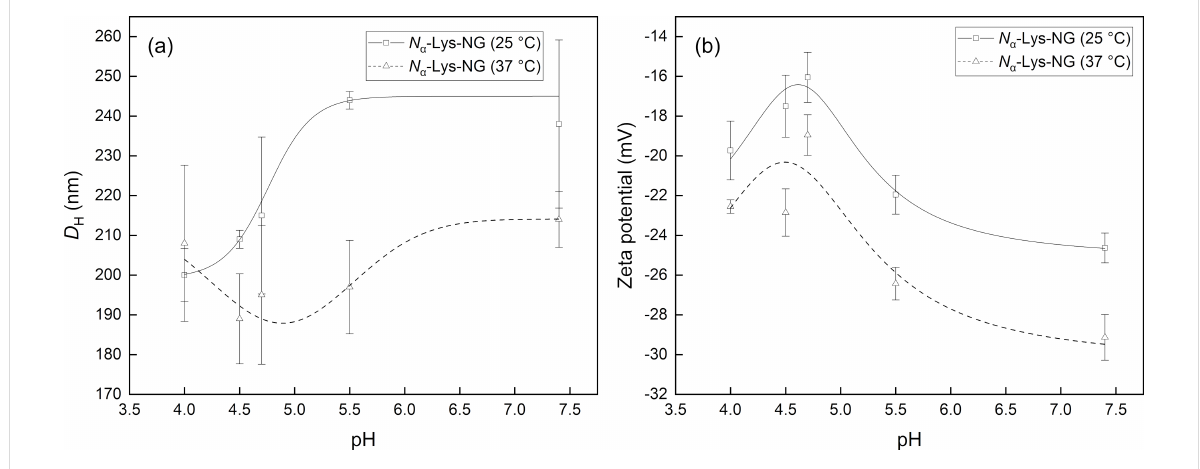
Figure 3: Dependence on the pH value of D H (a) and zeta potential (b) of N α -Lys-NG nanogel at 25 (squares) and 37 °C (triangles). The lines are to guide the eye.